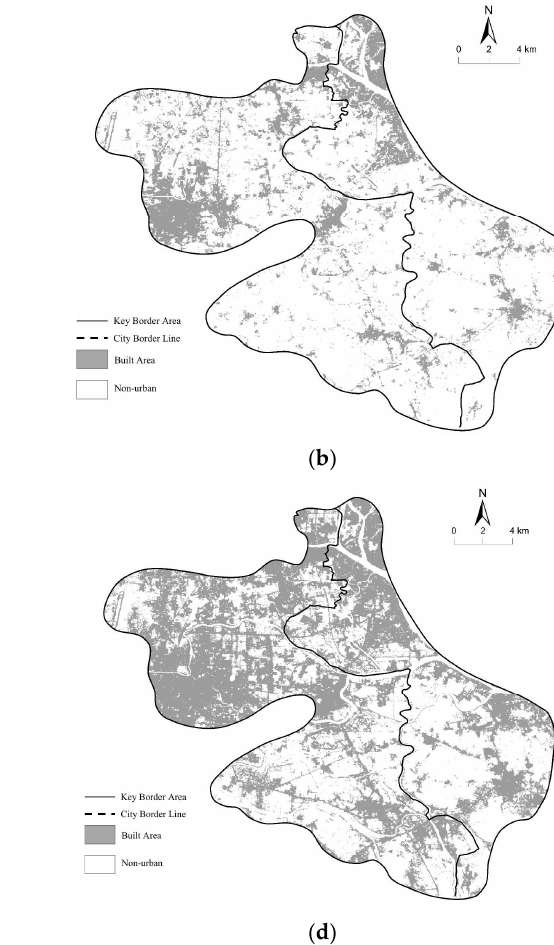
Figure 9. Spatial growth evolution of key border areas, 1985–2000. ( a ) Spatial growth in 1985; ( b ) Scheme 1990. ( c ) Spatial growth in 1995; ( d ) Spatial growth in 2000.